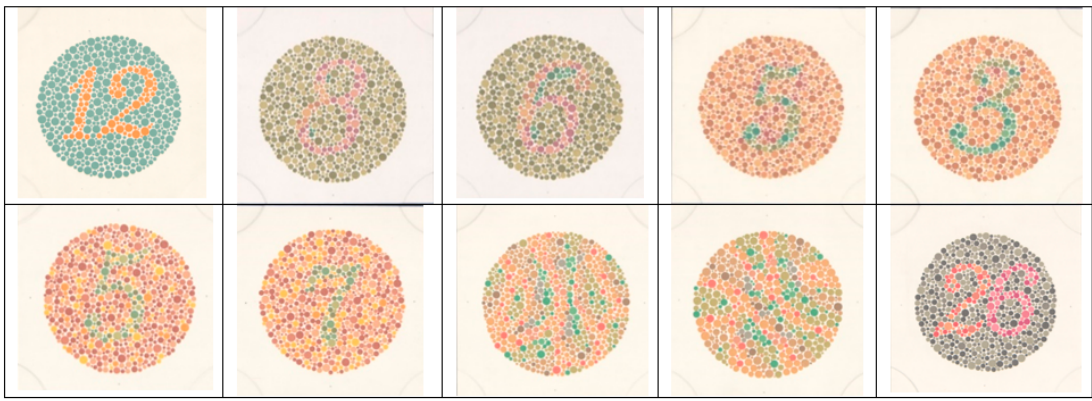
Figure 10. Set of 10 Ishihara plates selected to develop a quick virtual version test for colorblindness detection.